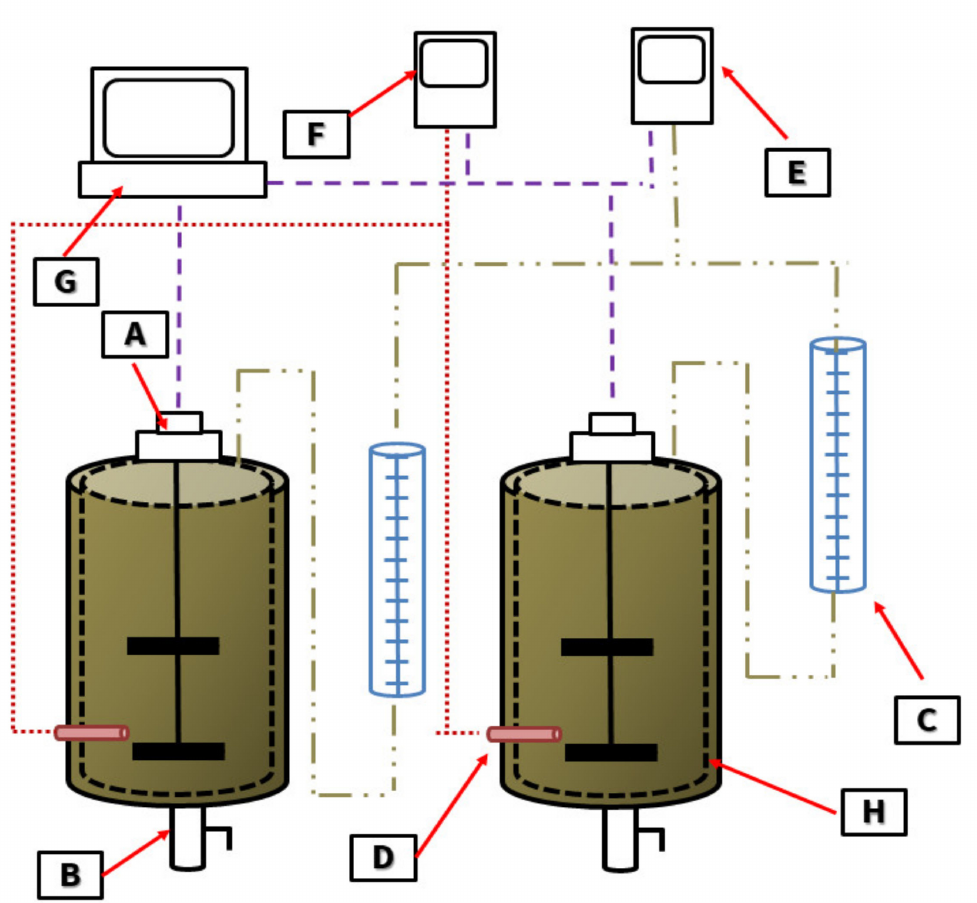
Figure 1. Laboratory AD reactors: A —mechanical stirrer, B —sampling point, C —tubes for mea- suring the volume of produced biogas, D —temperature probe, E —biogas composition meter, F —temperature meter, G —control system, H —water